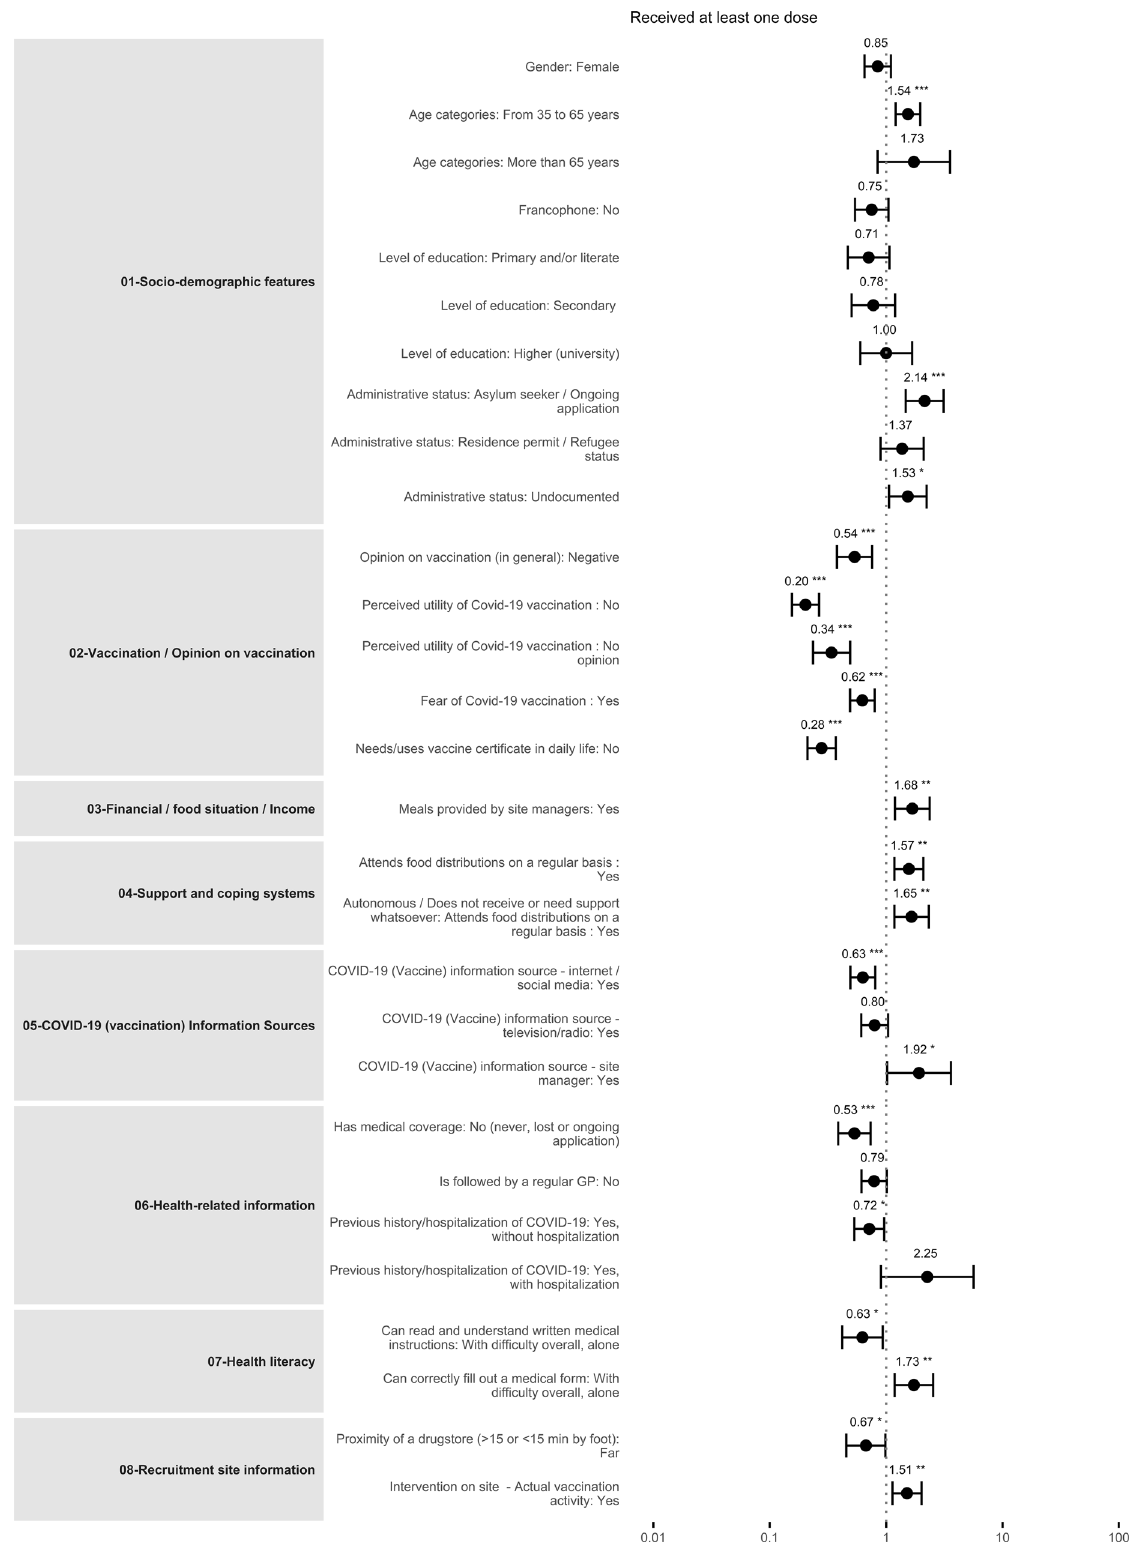
Fig. 4 Forest plot ( fi nal multilevel mixed logistic regression). Full dots represent estimates of Adjusted Odds-Ratio and fully capped lines their corresponding 95% Con fi dence Intervals. Asterisks indicate signi fi cant associations and their strength (* for p -values < 0.05, ** for p -values < 0.01 and *** for p -values < 0.001). Sample size for the fi nal model was 3508. Source data are available in Supplementary Data 6. A reproducibility guide for fi gures and tables is available in Supplementary Methods